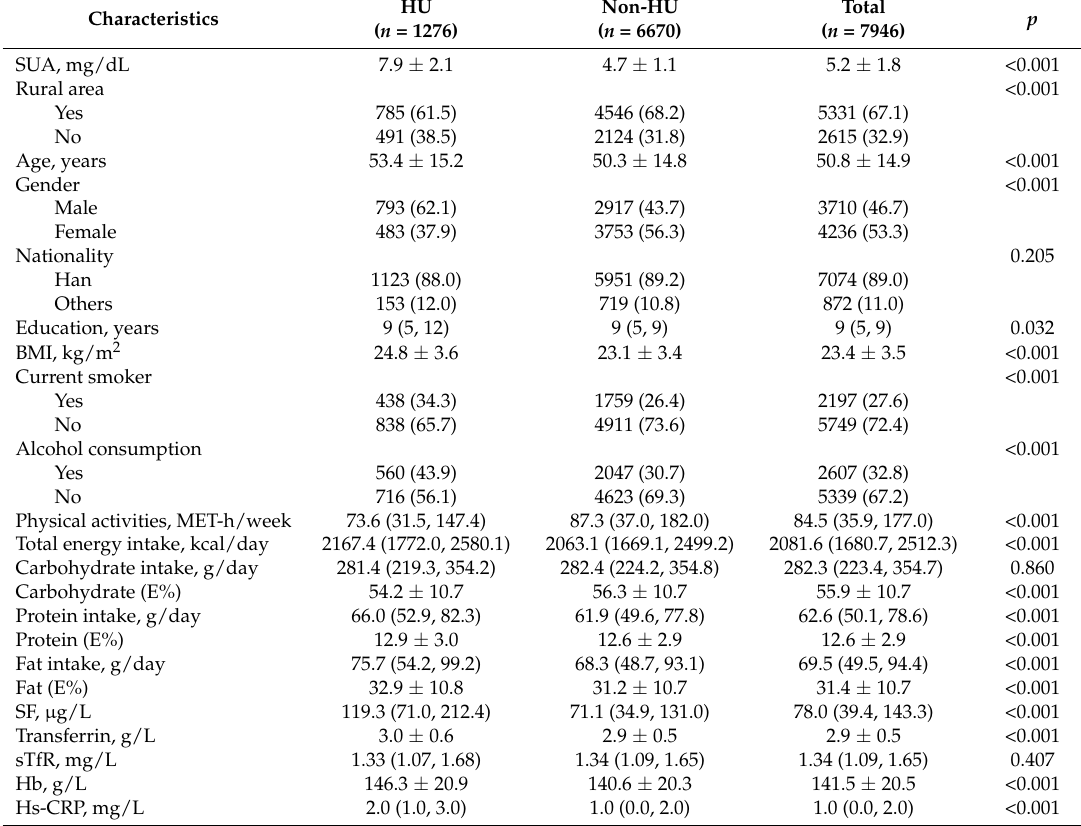
Table 1. Characteristics of the study participants from the China Health and Nutrition Survey in 2009.